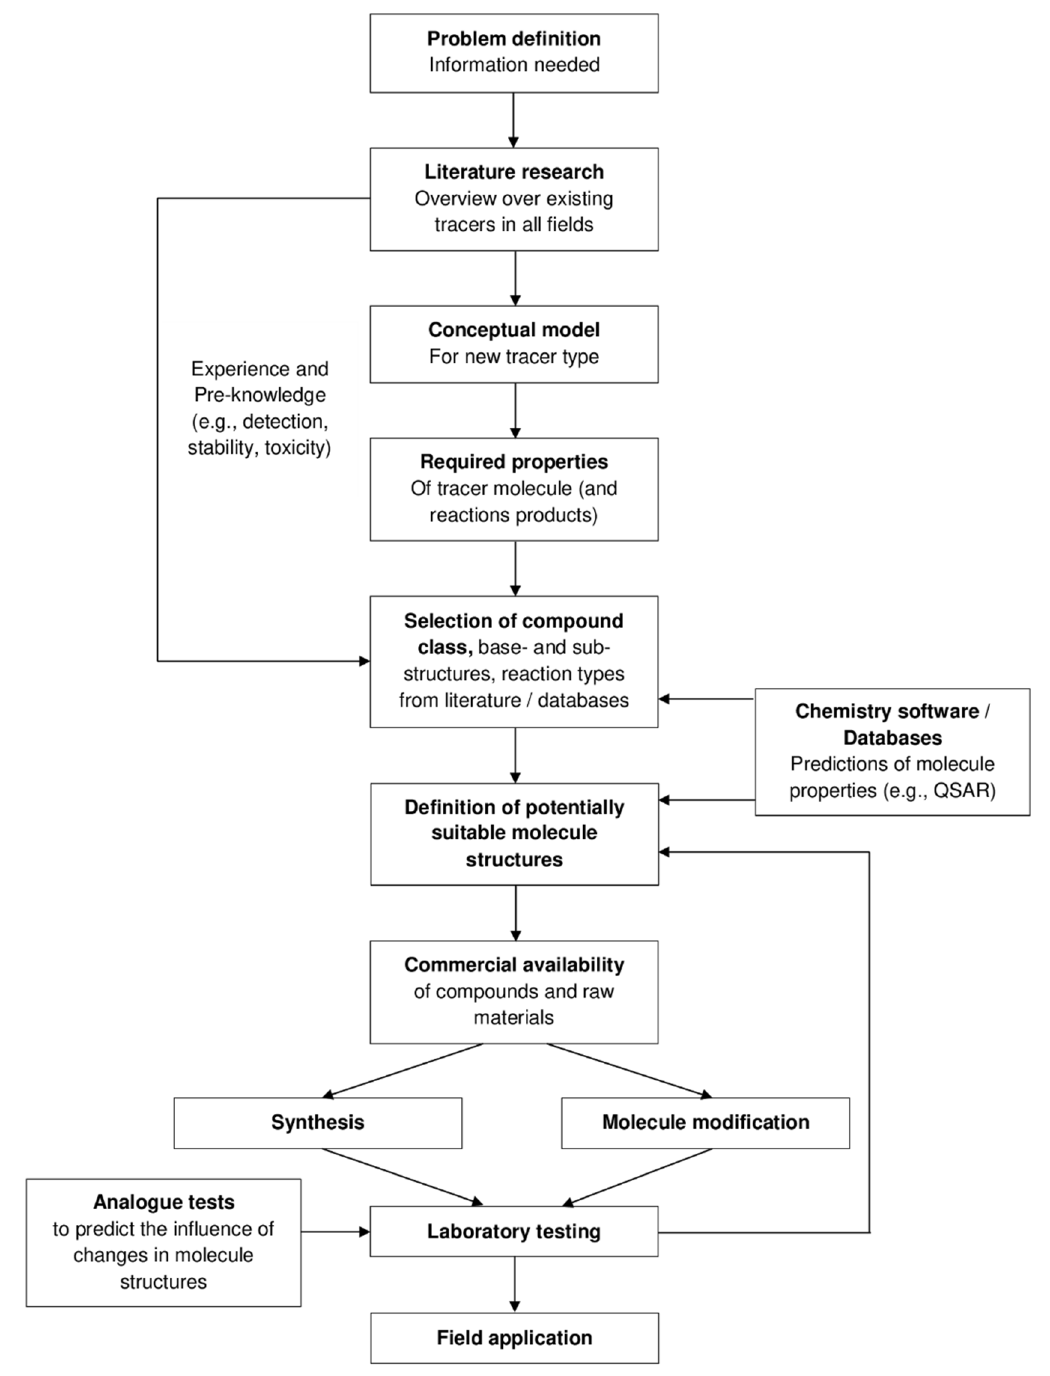
Figure 2. Schematic overview for the design of reservoir tracers.